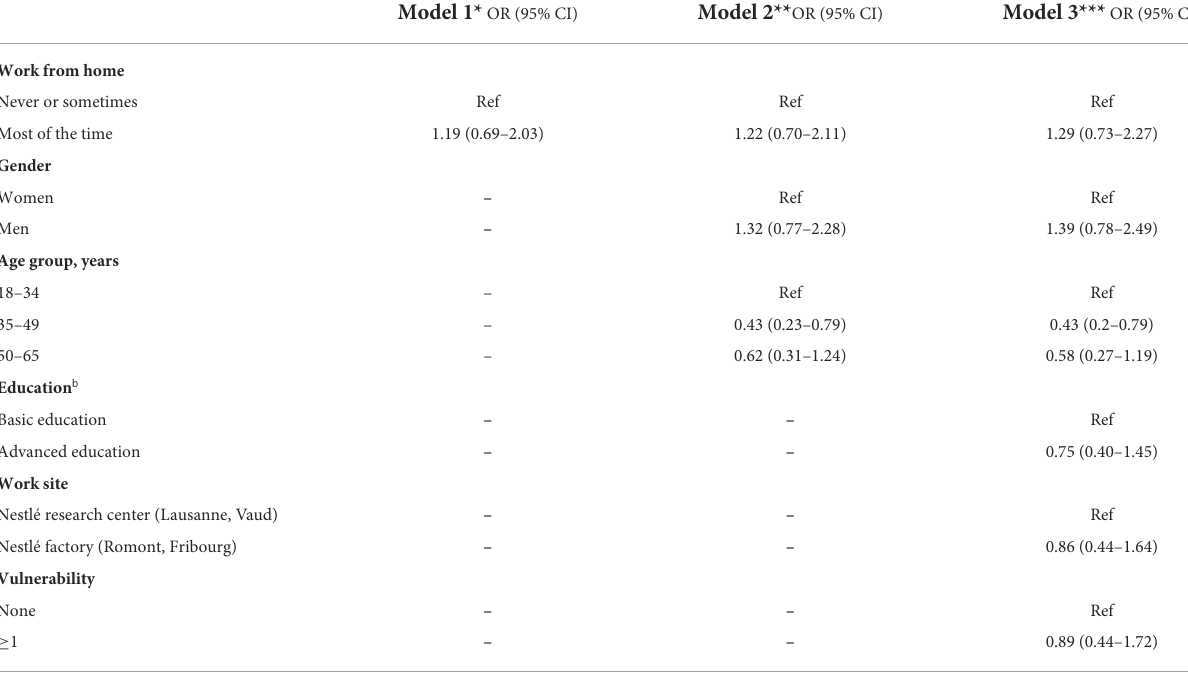
TABLE 2 Association between work from home and SARS-CoV-2 a infection assessed through logistic regression ( n =